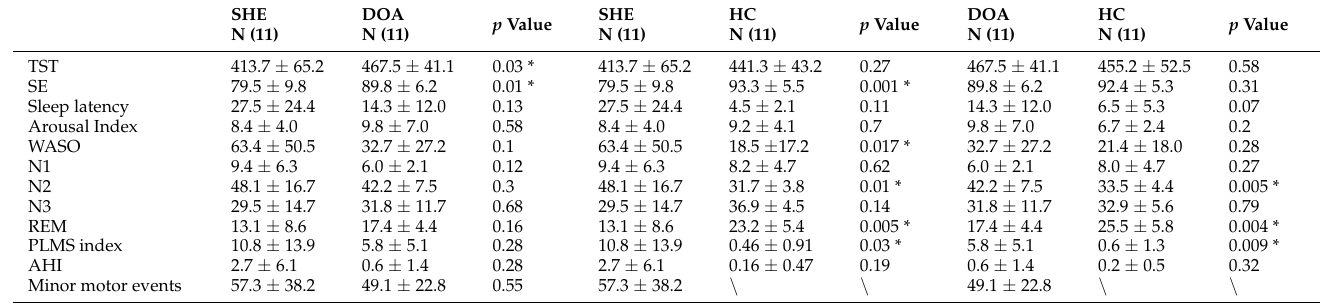
Table 2. Polysomnography features of the SHE group, DOA group, and healthy control